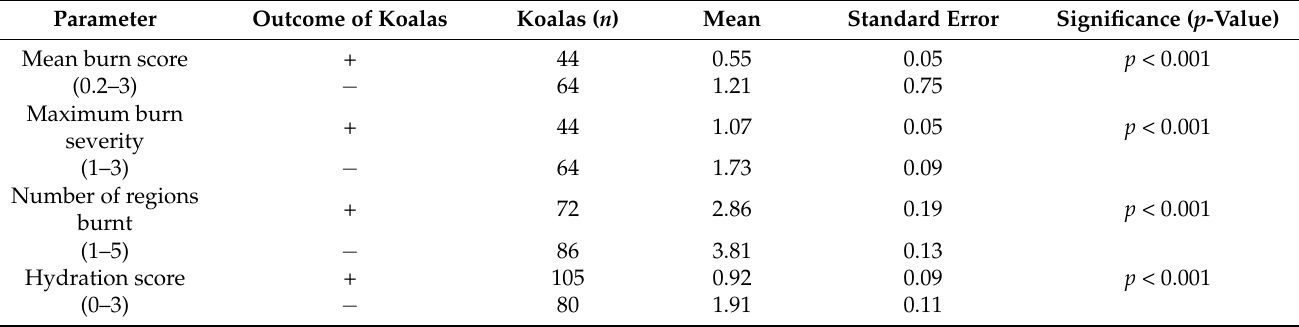
Table 4. Associations of positive (+) and negative ( − ) outcomes of rescued Kangaroo Island koalas, with burns and dehydration. Parameter Outcome of